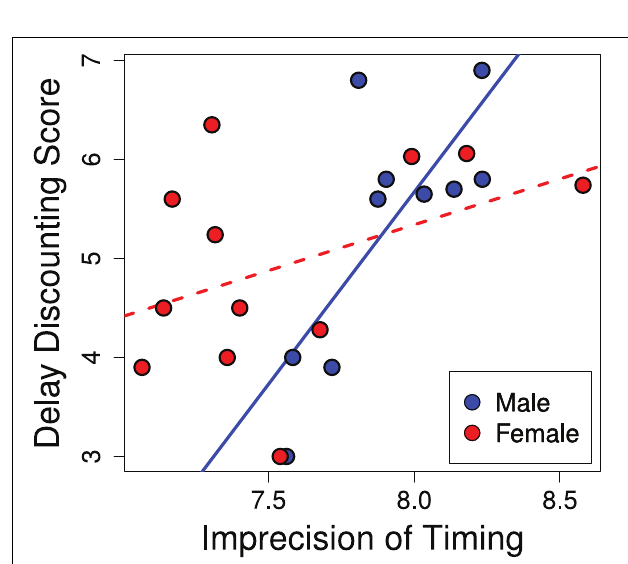
FIGURE 5 | Imprecision in timing predicts delay discounting. Greater variance in the estimation of the interval in the peak interval task was positively correlated with greater discounting scores ( R 2 = 0 . 40; p = 0 . 02). This effect was driven by the males (males b = 3 . 88; p = 0 . 007), while the females showed a trend in the same direction (females b = 0 . 93; p = 0 .